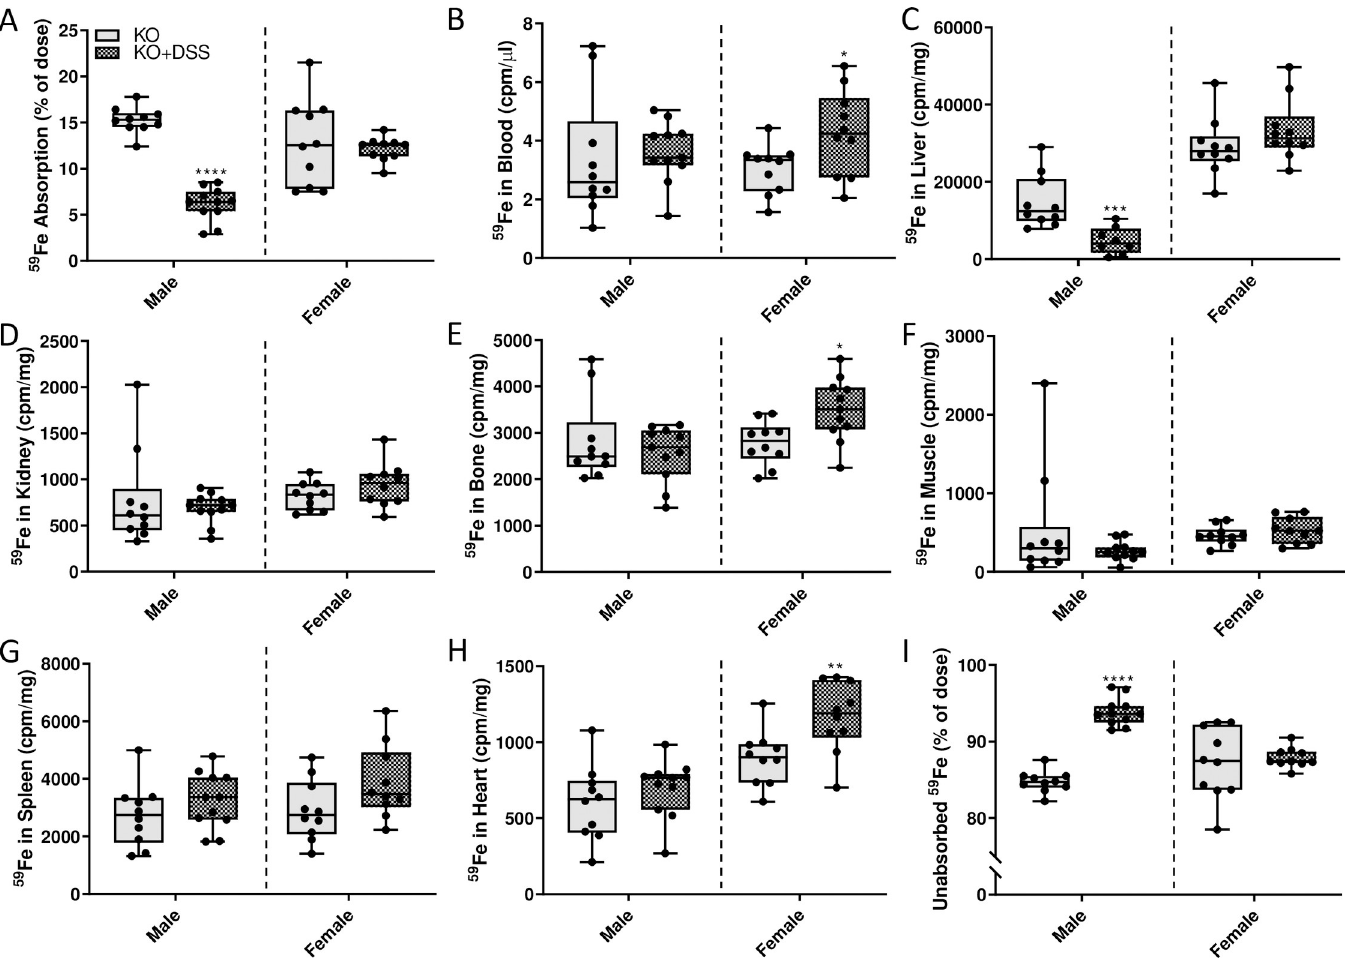
Fig 22. Radiotracer iron absorption studies in male and female Hamp -/- rats. Intestinal iron absorption and 59 Fe tissue distribution was determined in control or DSS- treated, 10-week-old hepcidin KO rats of both sexes using a standard oral gavage protocol. Iron absorption, as percent of 59 Fe radioactivity remaining in the animal 24 hours after dosing (minus radioactivity retained in the GI tract), is depicted in panel A . Distribution of 59 Fe in several tissues was also assessed by gamma counting ( B - H ). The percentage of unabsorbed 59 Fe is also depicted ( I ). All data are presented as box plots for 7–11 animals from two independent experiments and were analyzed separately by sex using a t-test ( � p < 0.0331; �� p < 0.0092; ��� p = 0.0001; ���� p < 0.0001).